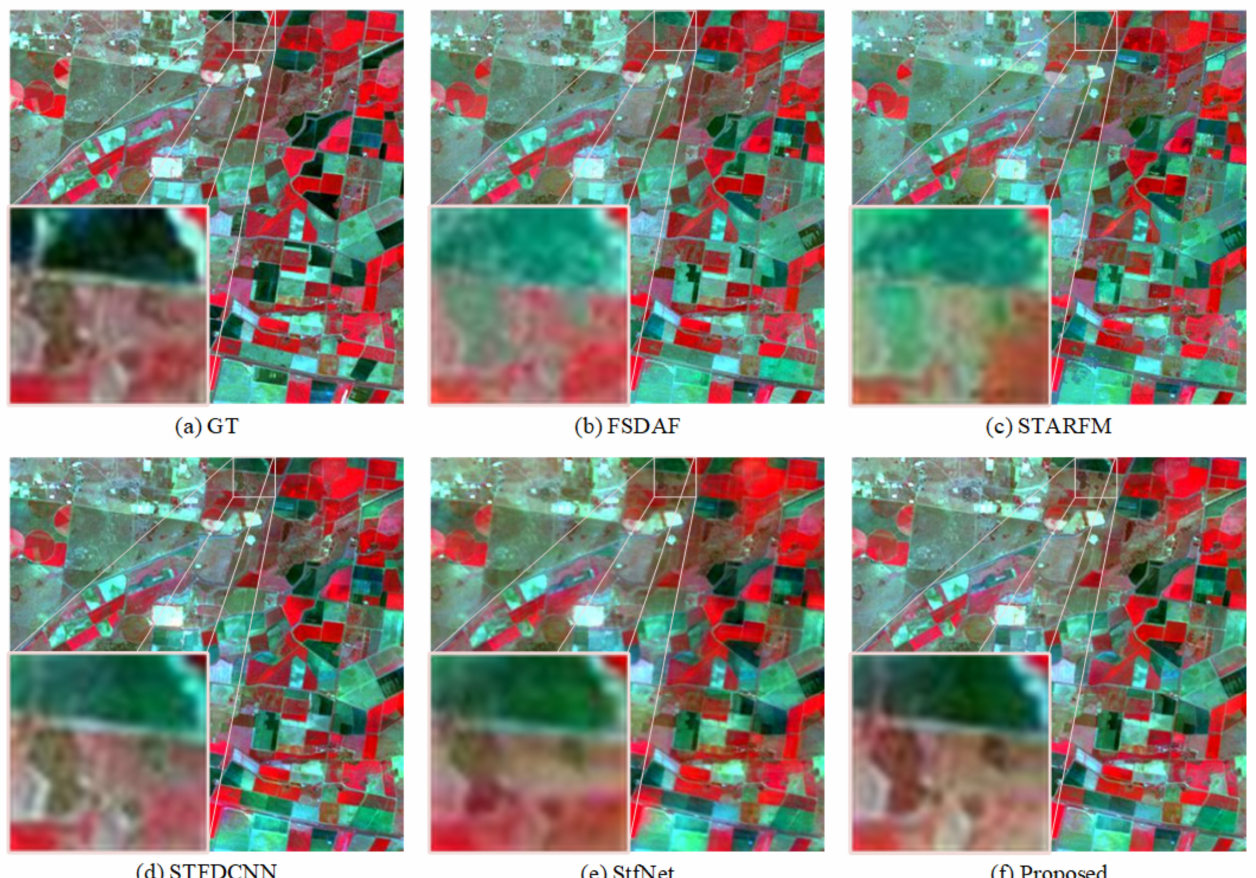
Figure 7. Prediction results for the target Landsat image (16 October 2001) in the CIA [31] dataset. Additionally, comparison methods include FSDAF [13], STARFM [8], STFDCNN [18] and StfNet [19], which are represented by ( b – e ) in the figure respectively. In addition, ( a ) represents the ground truth (GT) we got, and ( f ) represents the method we